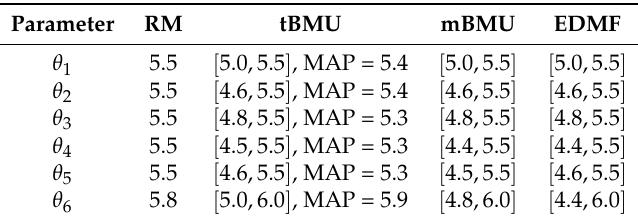
Table 12. Updated parameter ranges (posterior distributions) for Scenario 3 involving deflection measurements at ten locations.